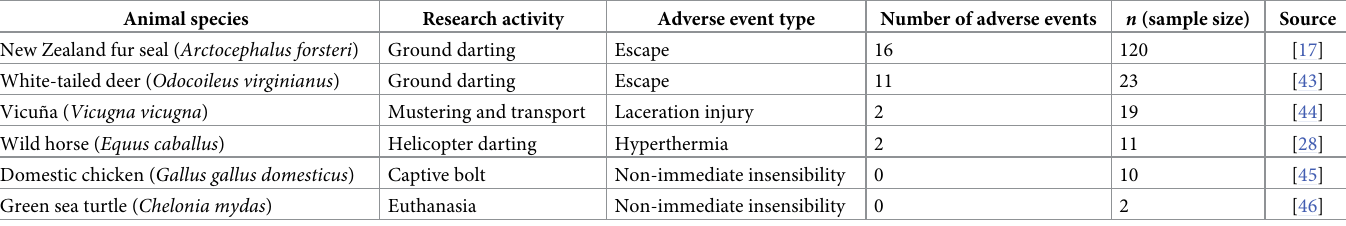
Table 2. Selected published studies reporting the frequency of adverse animal welfare events from research trials (not operational activities). Animal